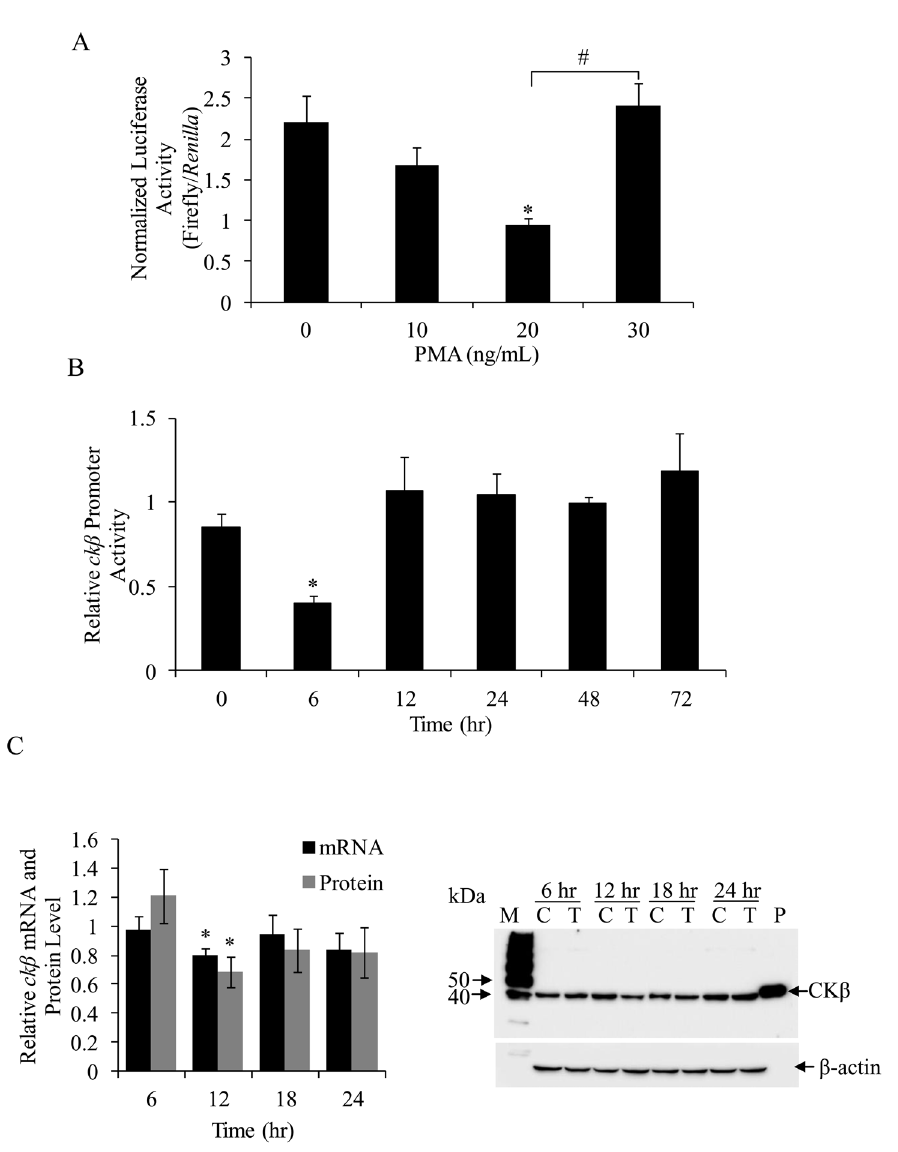
Figure 6. Effects of PMA concentration and treatment duration on ck b promoter activity. (A) MCF-7 cells were treated with 10, 20, or 30 ng/mL PMA for 6 hr. Each bar represents the mean ¡ SEM of triplicate samples from three independent experiments. (* p , 0.05 vs. DMSO control; # p , 0.05, within the PMA treatment group). (B) MCF-7 cells were treated with 20 ng/mL of PMA for 6 to 72 hr. The values shown are ck b promoter activities relative to their respective controls (control value is set at 1.0, * p , 0.05 vs. DMSO control). Each bar represents the mean ¡ SEM of triplicate samples from three independent experiments. (C) Effect of PMA treatment on the ck b mRNA and protein levels in MCF-7 cells. Cells were treated with 20 ng/mL of PMA or DMSO for 6 to 24 hr. Left panel: The levels of mRNA and proteins are relative to their respective controls (control value is set at 1.0, * p , 0.05 vs. DMSO control). Each bar represents the mean ¡ SEM of triplicate samples from three independent experiments. Right panel: The blot shown is representative of three independent experiments that produced similar results. M: SuperSignal Molecular Weight protein ladders (Thermo Scientific, USA), C: control, T: PMA treated, P: purified CK b protein (45 kDa) as reference.